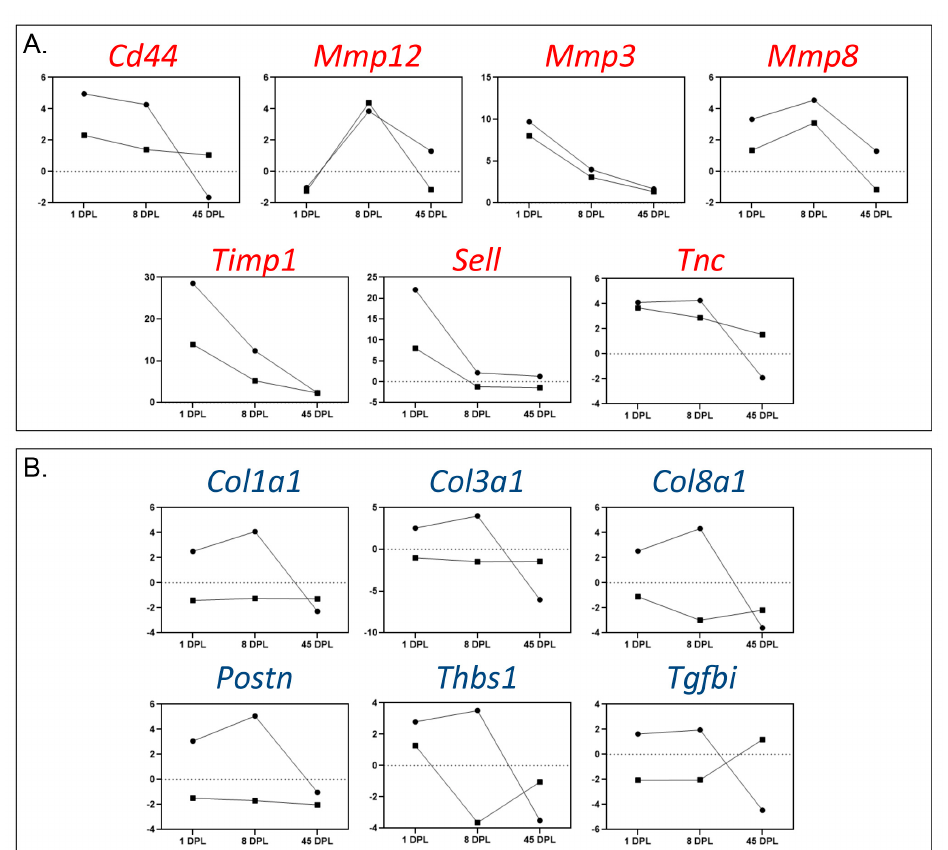
Figure 3. Time-course changes in the mRNA expression level of highly regulated genes. The figure illustrates the data obtained from the Polymerase Chain Reaction (PCR) array of genes regulated more than 4 times in at least one of the two segments and at least one considered time point. Genes are divided into similarly ( A ) or differently ( B ) regulated in the rostral and caudal segments. Circles represent the segment rostral while squares the region caudal to the lesion.